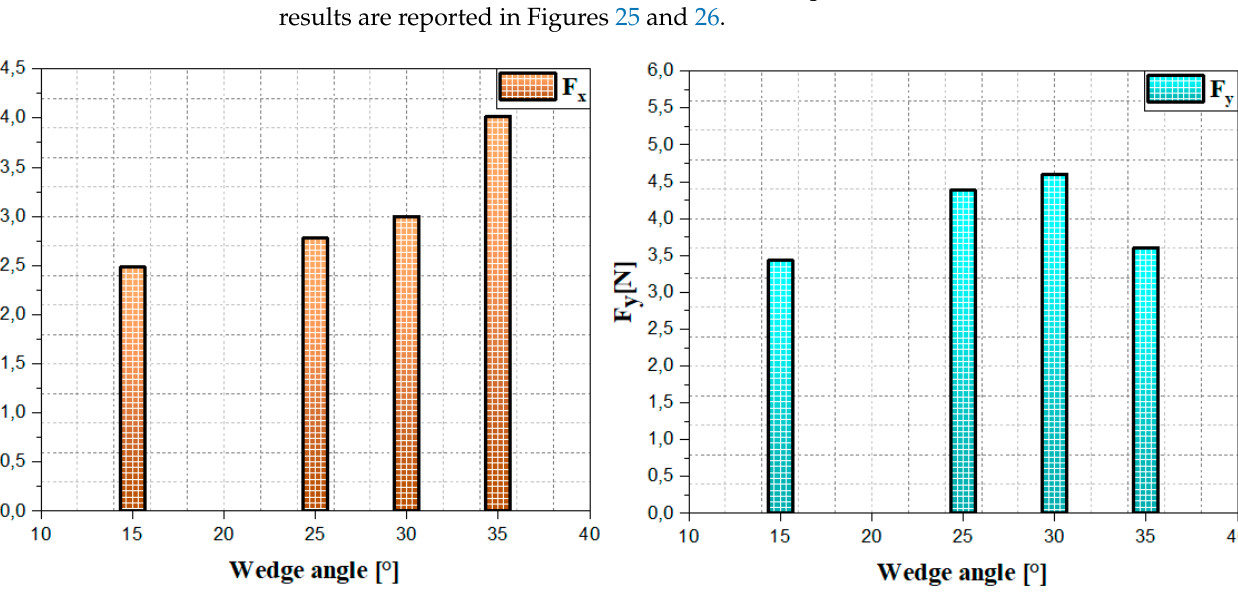
Figure 24. Accrual of material in the face of the cutting tool; wedge angle of the cutting blade is β n = 35°.